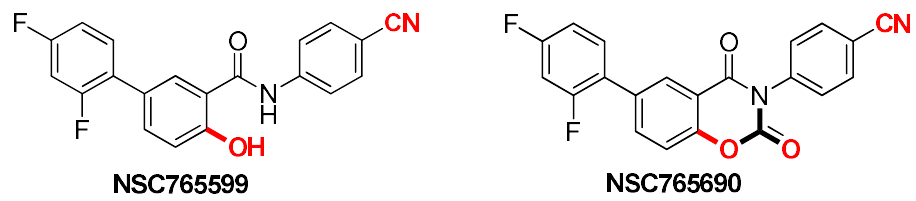
Figure 1. Chemical structures of NSC765599 (N-(4-cyanophenyl)-2′,4′-difluoro-4-hydroxy-[1,10- biphenyl]-3-carboxamide) and NSC765690 (4-(6-(2,4-Difluorophenyl)-2,4-dioxo-2H-benzo[e][1,3]- oxazin-3(4H)-yl)